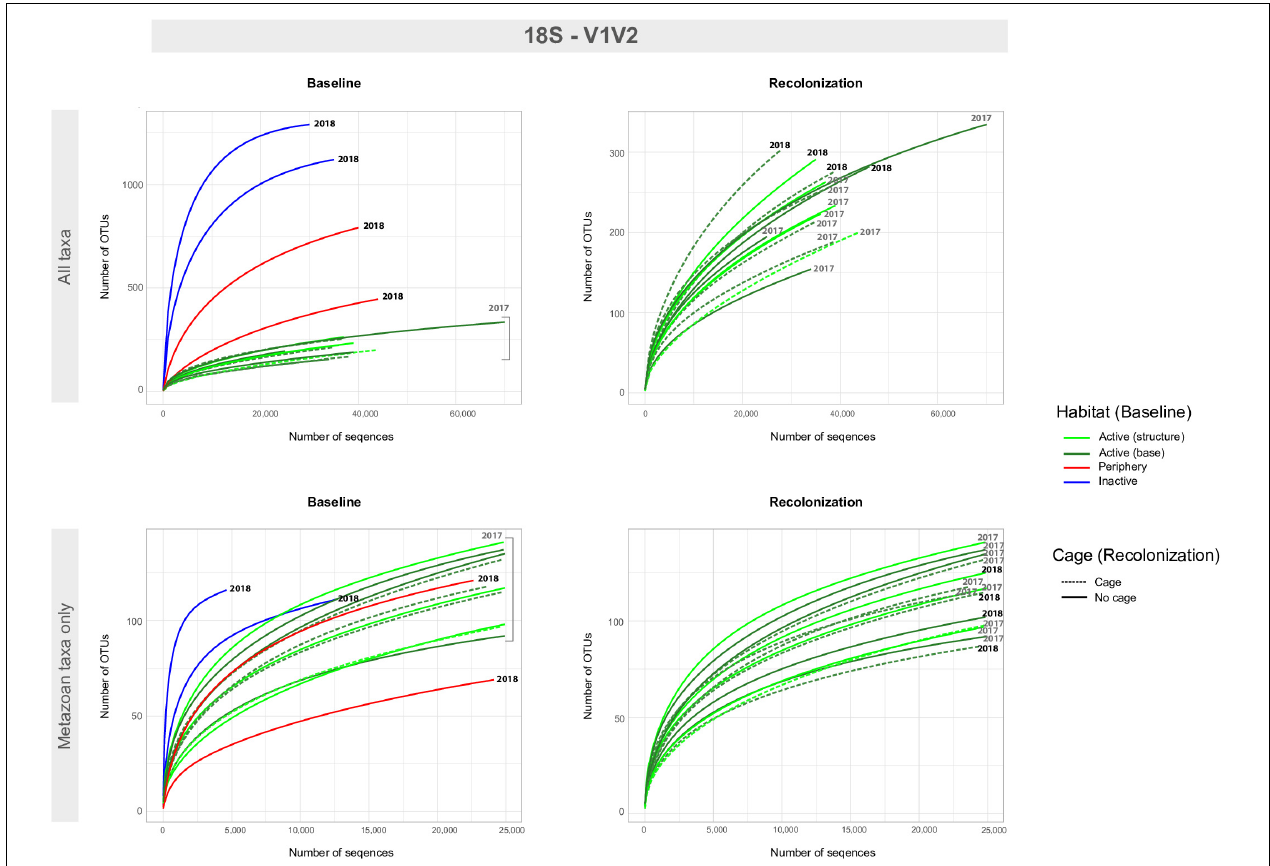
FIGURE 4 | Accumulation curves for the 18S-V1V2 eDNA dataset, for both baseline (left) and recolonization (right) data across all taxa (non-metazoans and metazoans, top ) and metazoan taxa only (bottom) . Baseline data focuses on sample communities from differing habitats/vent activity, as well as those from differing locations on the active edifice (base and structure). Recolonization data focuses on sample communities from differing years, as well as those that were caged against those non-caged at active sites. Note the difference in scales for number of OTUs and number of sequences between “All taxa” and “Metazoan taxa only.” Recolonization data are only available for the active